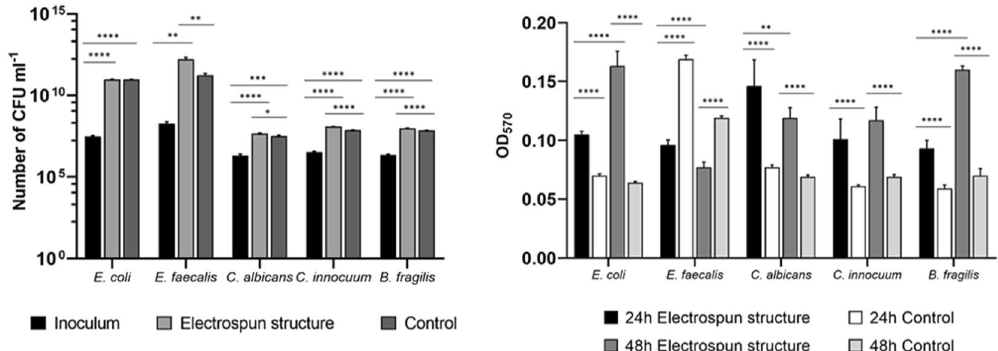
Figure 2. Growth and biofilm formation by E. coli , E. faecalis , C. innocuum , B. fragilis , and C. albicans on the electrospun gelatin scaffolds. Left: Microbial counts (number of CFUs ml -1 ) at the inoculum (black bars) and after 24 h of incubation on the electrospun gelatin structures (grey bars) and on controls (i.e. glass slides, dark grey bars); Right: microbial biomass after 24 and 48 h of incubation with and without (control) the electrospun structures. * p < 0.05, ** p < 0.01, *** p < 0.001, **** p <